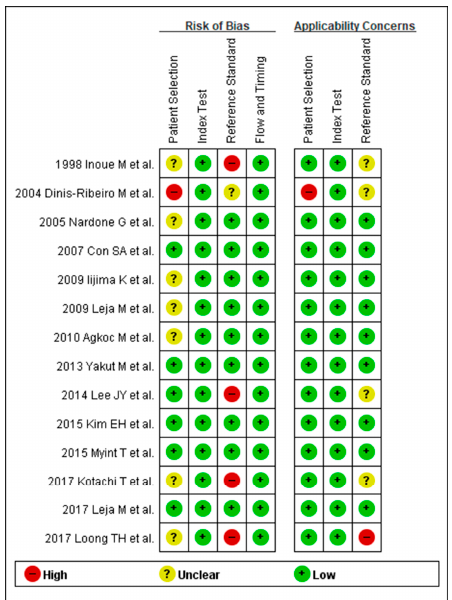
Figure 2. QUADAS-2 for the assessment of the methodological qualities of all the enrolled studies for the diagnosis of CAG. ( + ) denotes low risk of bias, (?) denotes unclear risk of bias, (–) denotes high risk of bias. QUADAS-2, Quality Assessment of Diagnostic Accuracy Studies-2; CAG, chronic atrophic gastritis.